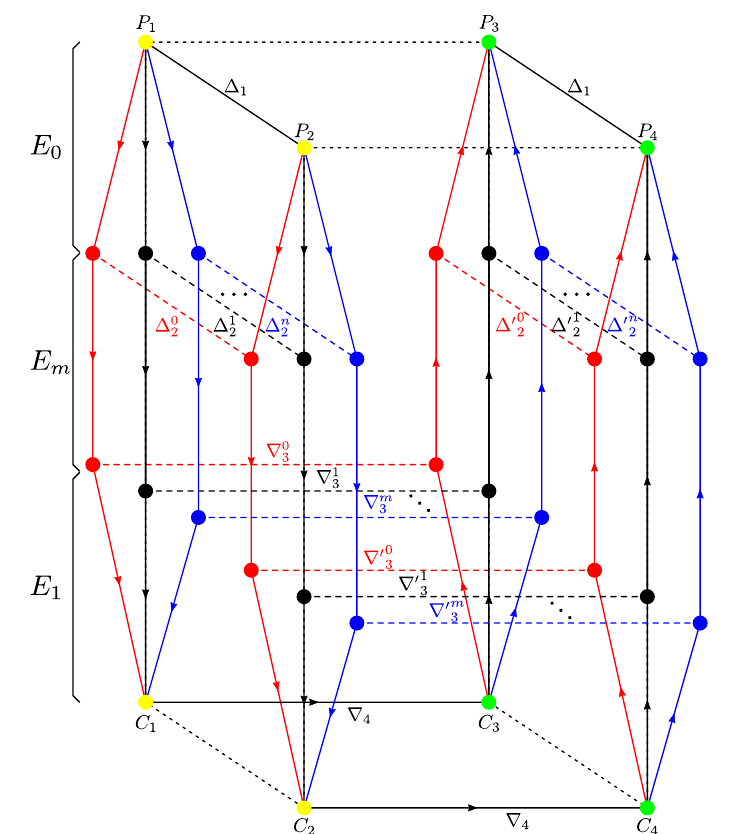
Figure 4: Cluster of sandwich